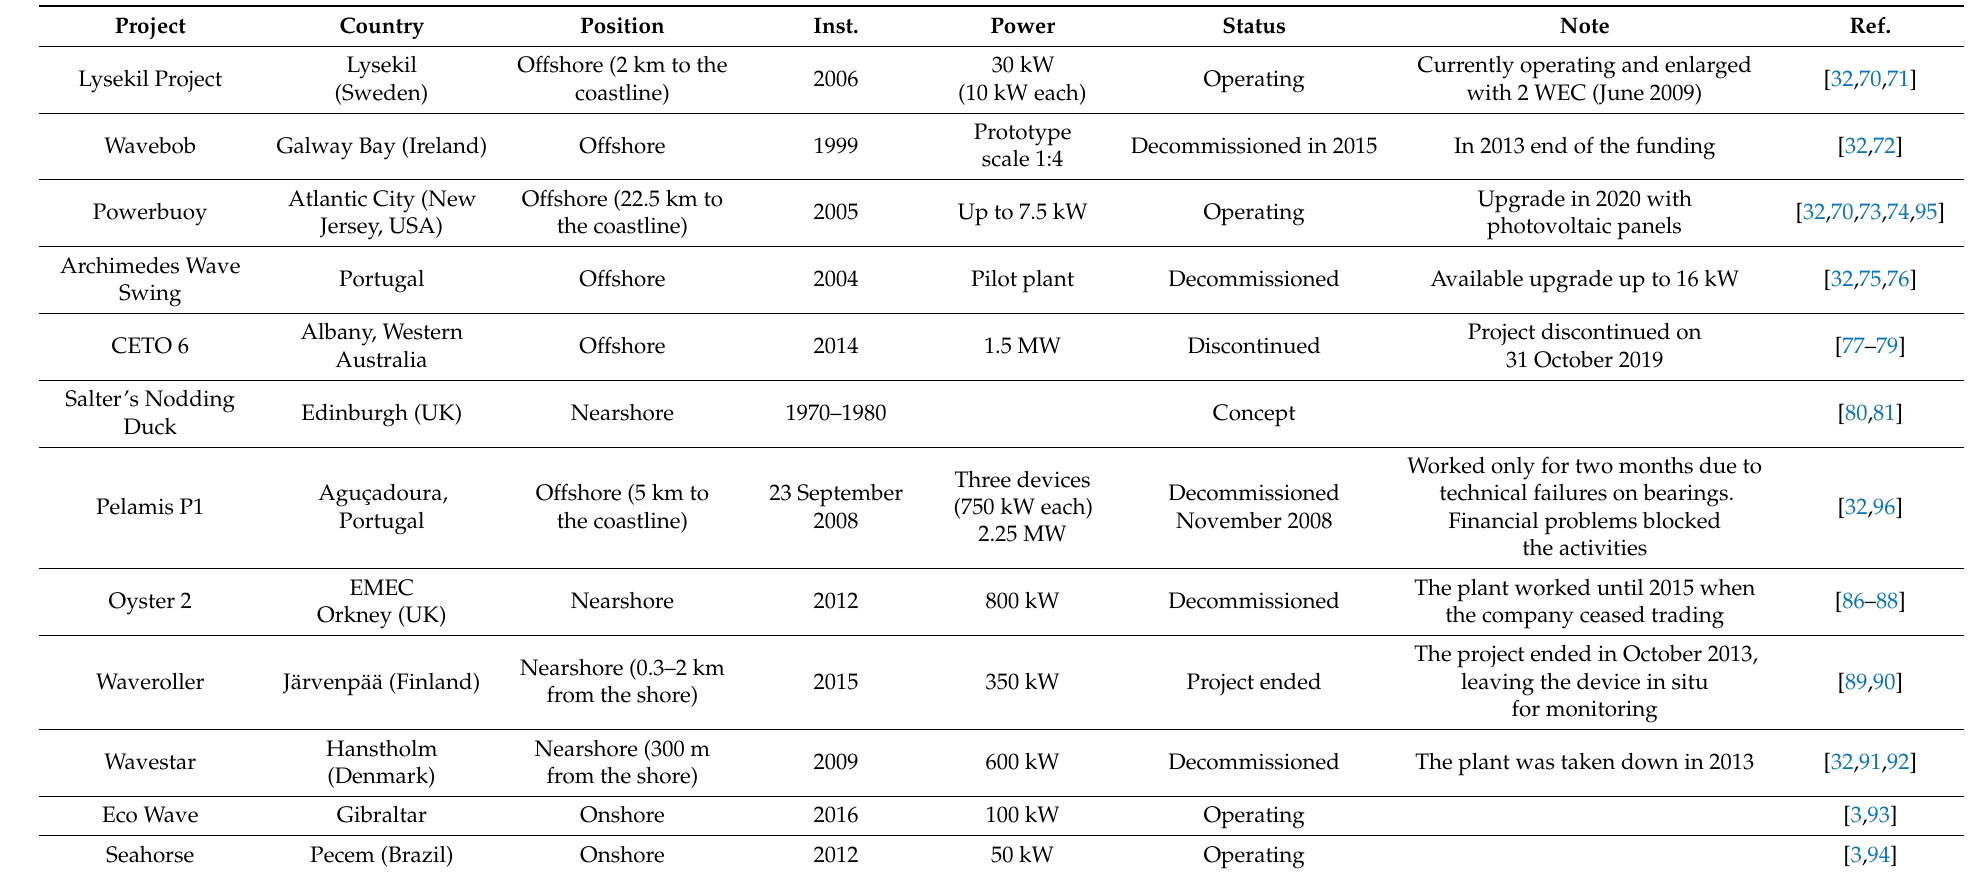
Table 4. Summary of the main WAB